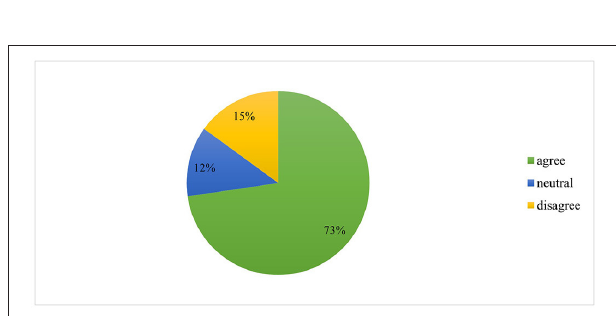
FIGURE 7 | Creation of a shopping list before food shopping. Source: own processing and data collection.